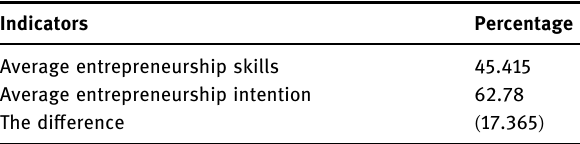
Table 8: Level of risk taking of poor farmers ( % ) Risk - taking indicators